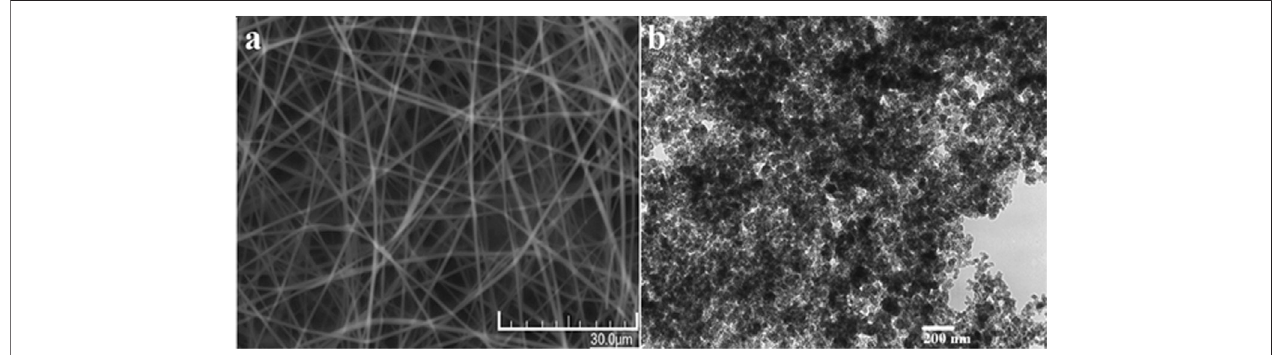
FIGURE 3 | Microscopy of electrodes (A) SEM image of electrosorum lignin anode before bio fi lm development (B) TEM image of catalyst on carbon.